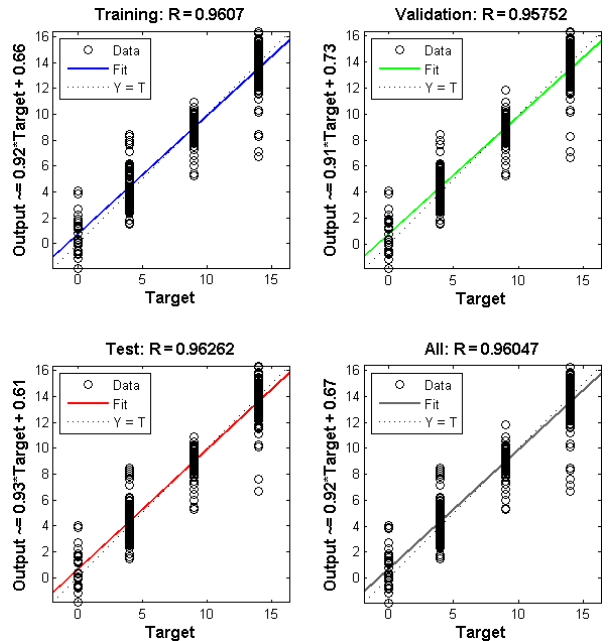
Figure 17. Regression plots.